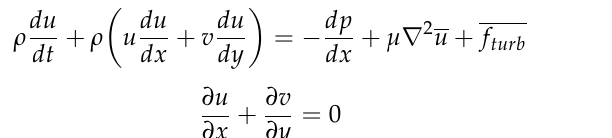
The boundaries of the flow domain were applied with a surface roughness of 28.4 µ m,